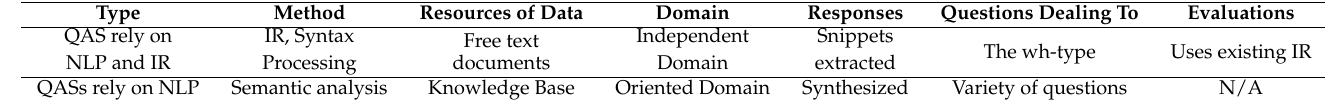
Table 2. Characteristics of